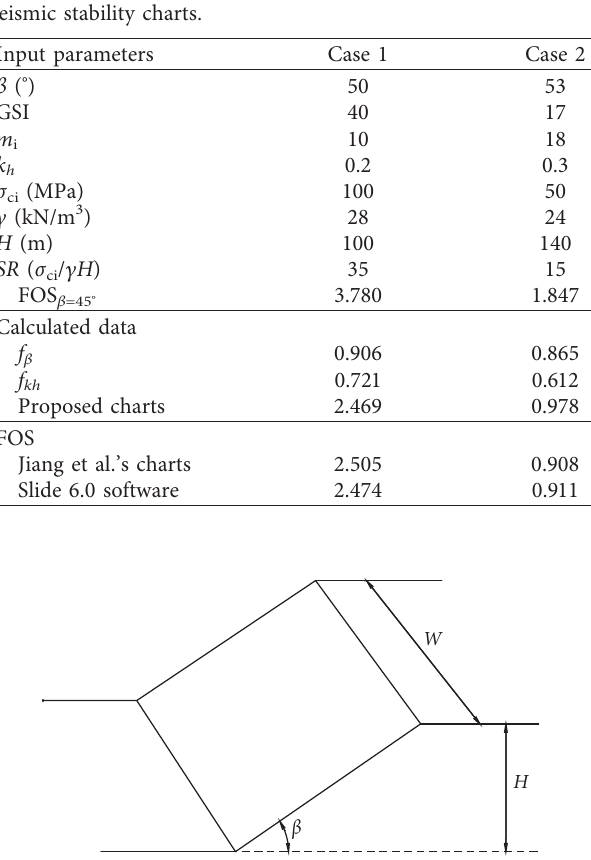
Figure 12: Sketch of 3D rock slope model with a limited width W .